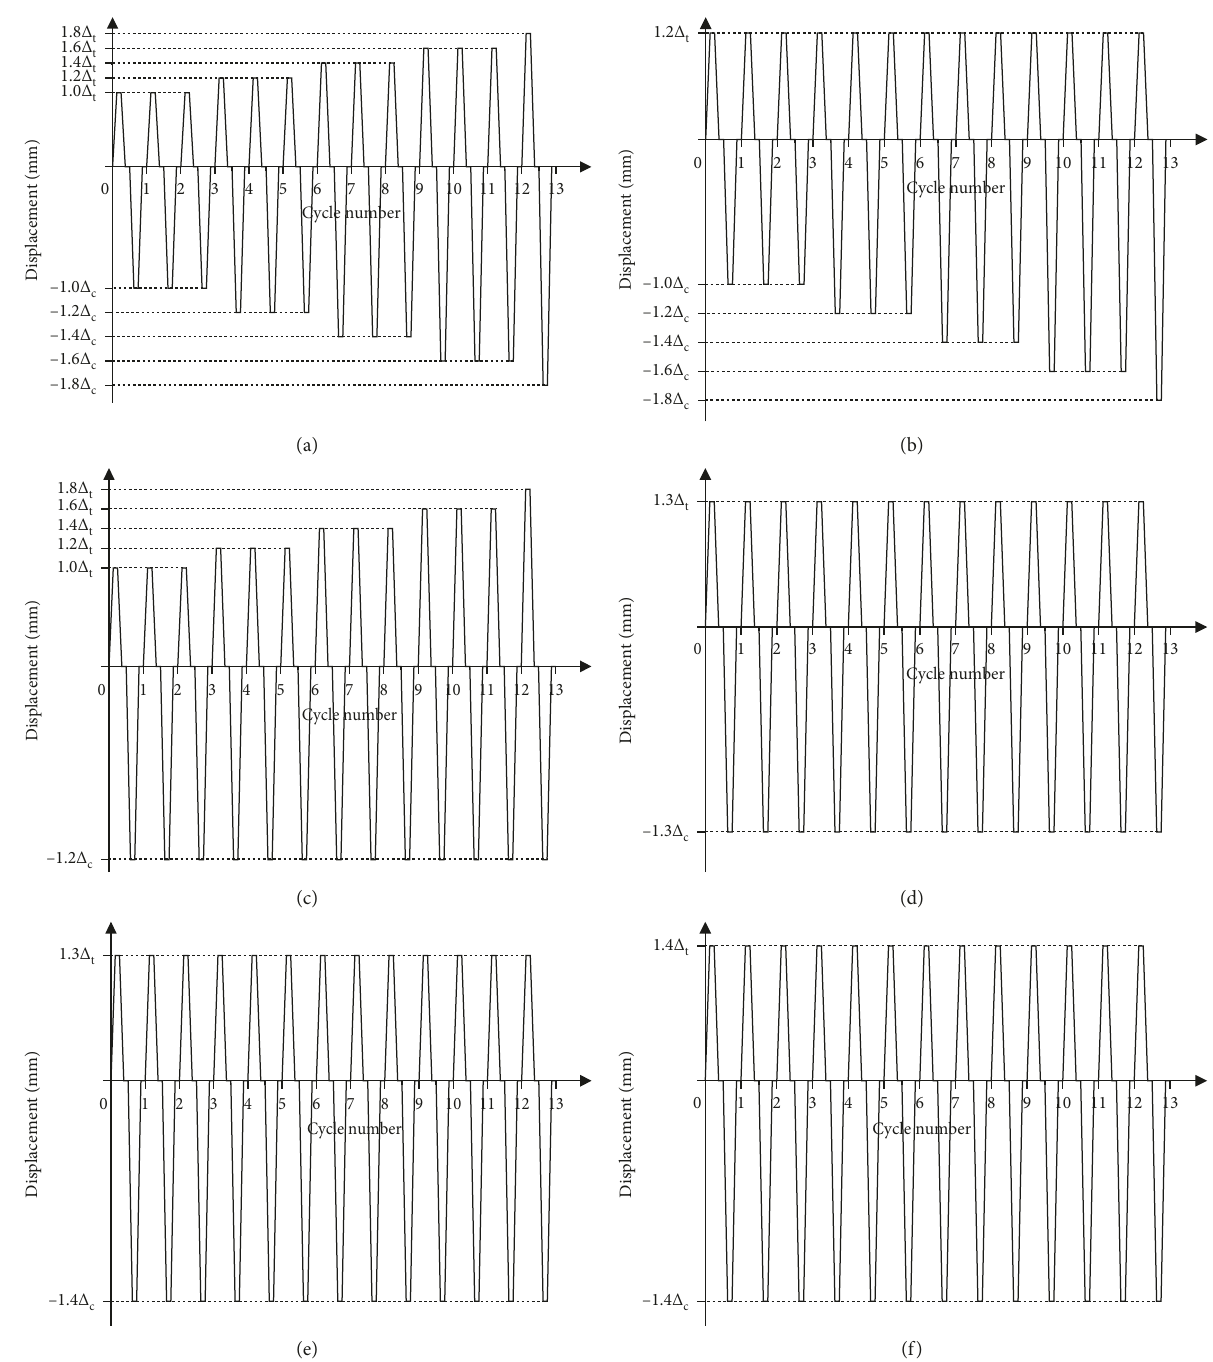
Figure 10: Loading systems: (a) loading system I, (b) loading system II, (c) loading system III, (d) loading system IV, (e) loading system V, and (f) loading system